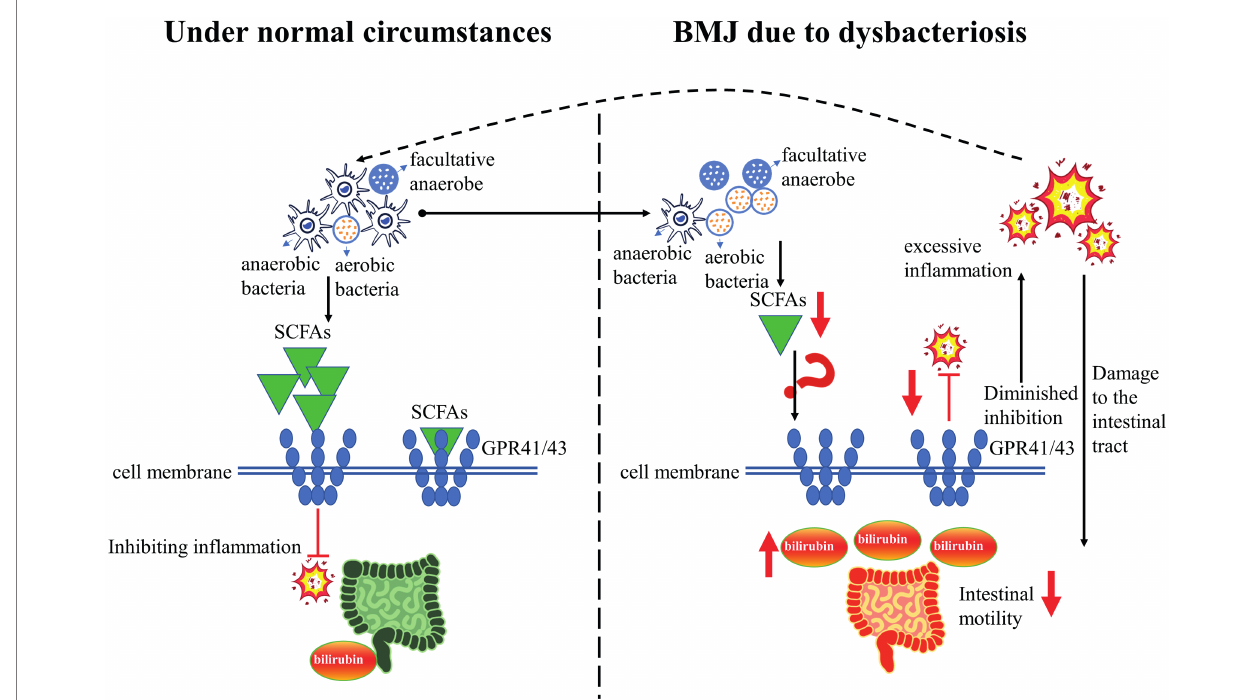
FIGURE 2 A simplified schematic diagram: dysbacteriosis leads to a decrease in SCFA, and downregulate the GPR41/43 pathway, resulting in the occurrence of